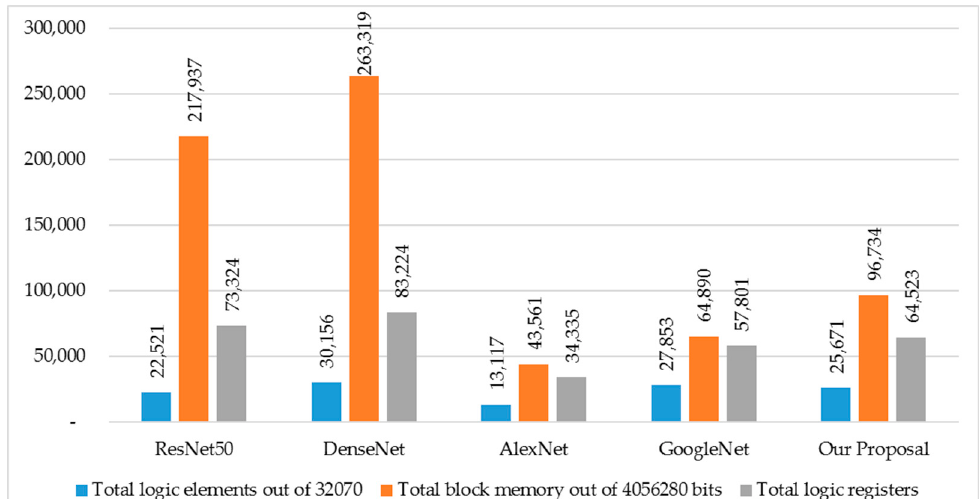
Figure 8. Numbers of resources for DE1-Soc.